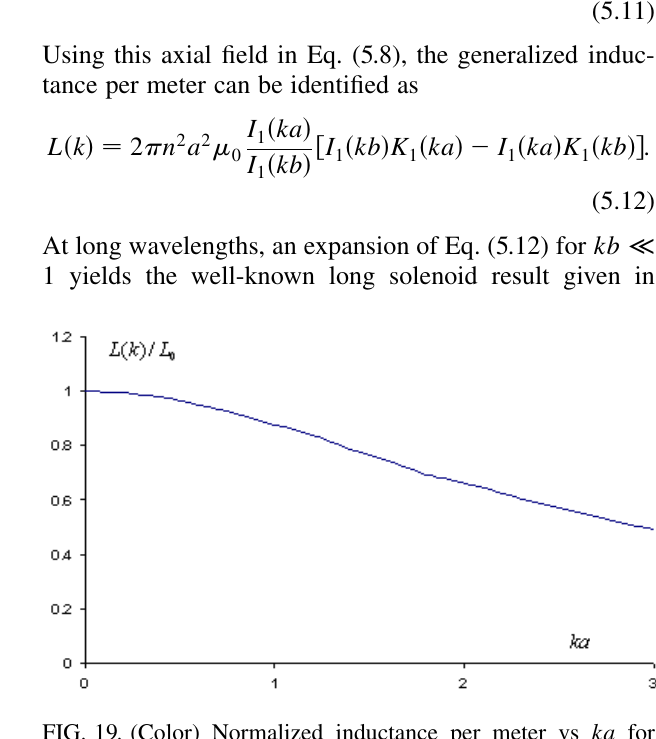
FIG. 19. (Color) Normalized inductance per meter vs ka for a=b (cid:3) 0 : 6